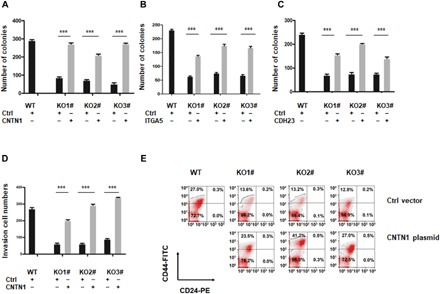
Rescue of tumorigenic phenotypes in enhancer-deleted 22Rv1 cells following the re-expression of candidate enhancer targets.Quantification of soft agar colony formation assays of WT 22Rv1 cells, three enhancer-deleted cell lines (KOs 1 to 3), and KO cells re-expressing CNTN1 (A), ITGA5 (B), or CDH23 (C). Data represent means ± SEM of three independent experiments. ***P < 0.001. (D) Quantification of Transwell assays of WT 22RVv1 cells, three enhancer-deleted cell lines (KOs 1 to 3), and KO cells re-expressing CNTN1. Data represent means ± SEM of three independent experiments. ***P < 0.001. (E) The percentage of CD44+CD24− cells in WT 22Rv1 cells, three enhancer-deleted cell lines (KOs 1 to 3), and CNTN1 re-expressed KO cells.